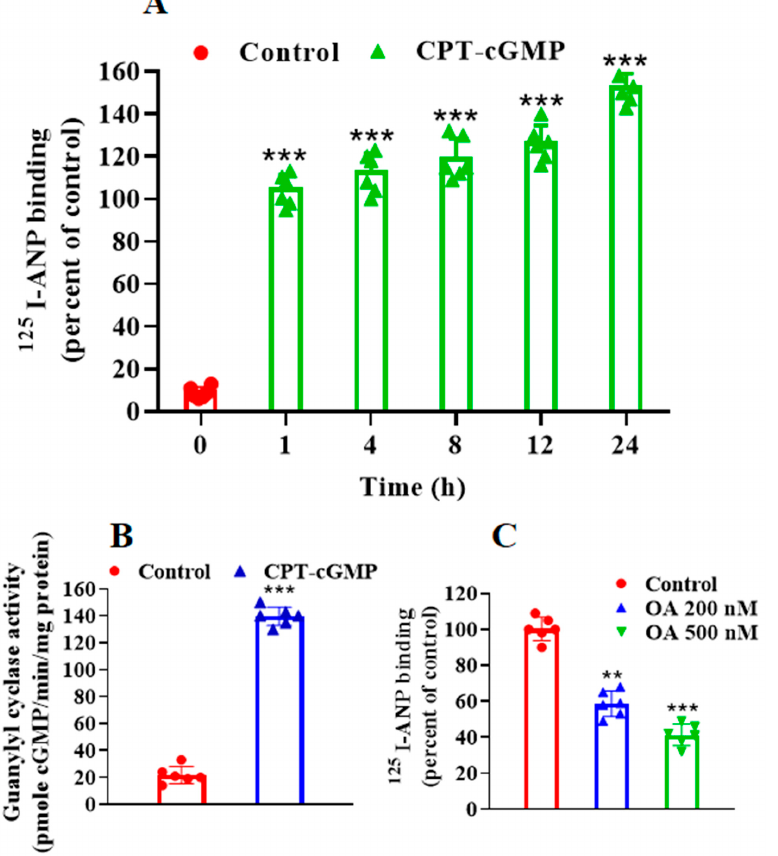
Figure 6. The effect of CPT-cGMP and okadaic acid pretreatments on 125 I-ANP binding to NPRA and guanylyl cyclase activity. ( A ) Confluent MA-10 cells were pretreated with 1 µ M concentrations of 8-(4-chlorophenylthio)-cGMP (CPT-cGMP) for the indicated times at 37 ◦ C and then transferred to 4 ◦ C. Receptor binding was carried out as described under the Section 4. ( B ) MA-10 cells were treated with 1 mM CPT-cGMP for 24 h. The medium was aspirated. Cells were incubated with glycine acetate buffer (pH 3.8) for 2 min and plasma membranes were prepared to assay the GC activity. ( C ) Confluent MA-10 cells were pretreated with CPT-cGMP in the presence or absence of indicated concentrations of okadaic acid (OA) for 24 h at 37 ◦ C. Receptor binding was carried for 30 min at 4 ◦ C as described in the Section 4. Values are expressed as means ± SE of 6 determinations. ** p < 0.01, *** p < 0.001 (untreated vs. drug-treated